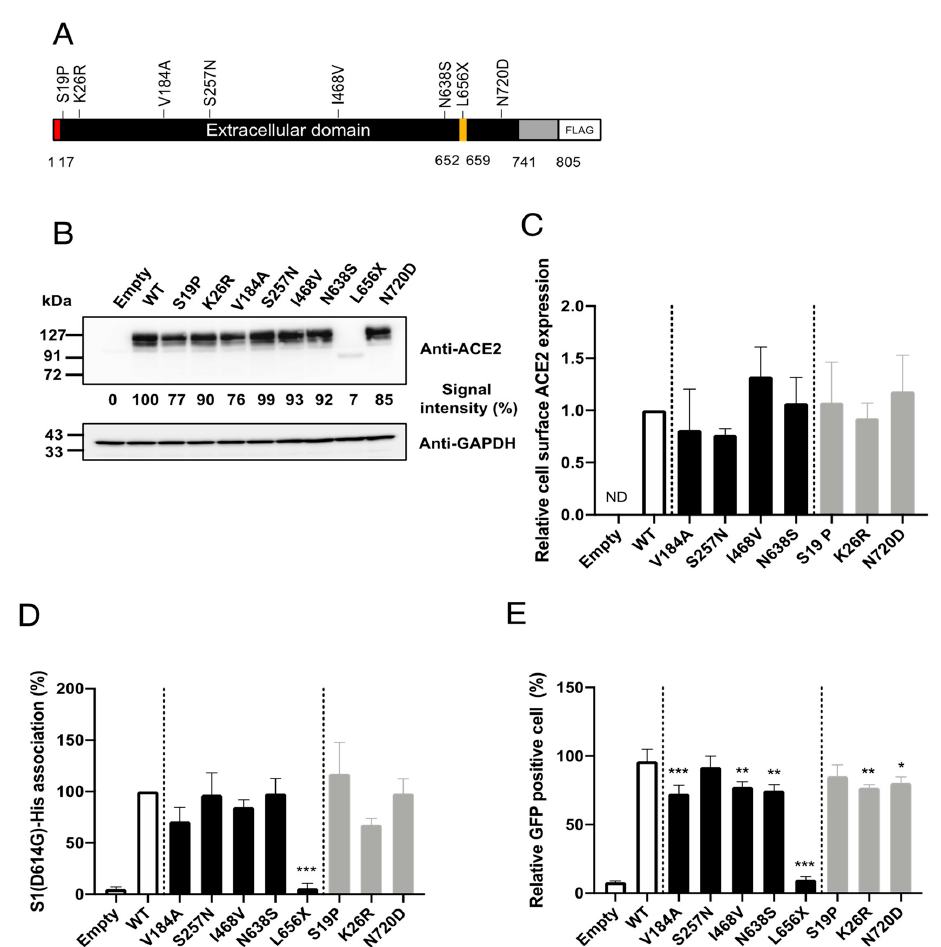
Figure 2. Effects of amino acid substitutions corresponding to SNPs in ACE2 on binding to SARS-2-S and cell entry mediated by SARS-2-S in vitro. ( A ) Schematic diagram of the construct used to express the ACE2 variants in this study. Amino acid substitutions corresponding to the SNPs were independently introduced into C-terminally FLAG-tagged human ACE2. Red, signal peptide; yellow, ADAM17 cleavage site; gray, transmembrane and cytoplasmic regions. ( B ) HEK293T cells were transfected with plasmids encoding either FLAG-tagged WT or variant ACE2 proteins. The pCMV6-Entry vector only (Empty) was used as the negative control. ACE2 and GAPDH levels in the total cell lysates were analyzed by western blotting. ( C ) HEK293T cells transfected with plasmids expressing either FLAG-tagged WT or variant ACE2 proteins were biotin-labeled and the cell-surface proteins were pulled down with streptavidin beads. The levels of WT ACE2 and ACE2 variants on the cell surface (in the pulled down samples) and in the total cell lysate were then analyzed by western blotting. The levels of transferrin receptor 1 (TFRC) on the cell surface and in the total cell lysate were also analyzed as an internal control. The ratios of the levels of the protein on the cell surface to that in the total cell lysate were calculated for the WT and each variant after first normalizing the data to the corresponding ratios for TFRC. The value for WT ACE2 was set to 1. ( D ) HEK293T cells transfected with plasmids expressing either FLAG-tagged WT or variant ACE2 proteins were incubated with rSARS-2-S1(D614G), and the levels of rSARS-2-S1(D614G) binding to these cells were analyzed by flow cytometry. The value for WT ACE2 was set to 100%. ( E ) HEK293T cells transfected with plasmids expressing either FLAG-tagged WT or variant ACE2 proteins were inoculated with rVSV ∆ G-GFP/SARS-2-S(D614G). After 16 h, the proportions of GFP-positive cells were determined with a high-content imaging system. (C–E) Data represent the means + S.D. of at least three independent experiments. White bars, controls (vector-only transfected or WT ACE2); black bars, East Asian population-specific SNPs; gray, non-East Asian population-specific SNPs. Empty, transfected with pCMV6-Entry vector only as the negative control; ND, not detected; WT, wild-type ACE2. *, p < 0.05; **, p < 0.01; ***, p < 0.001.